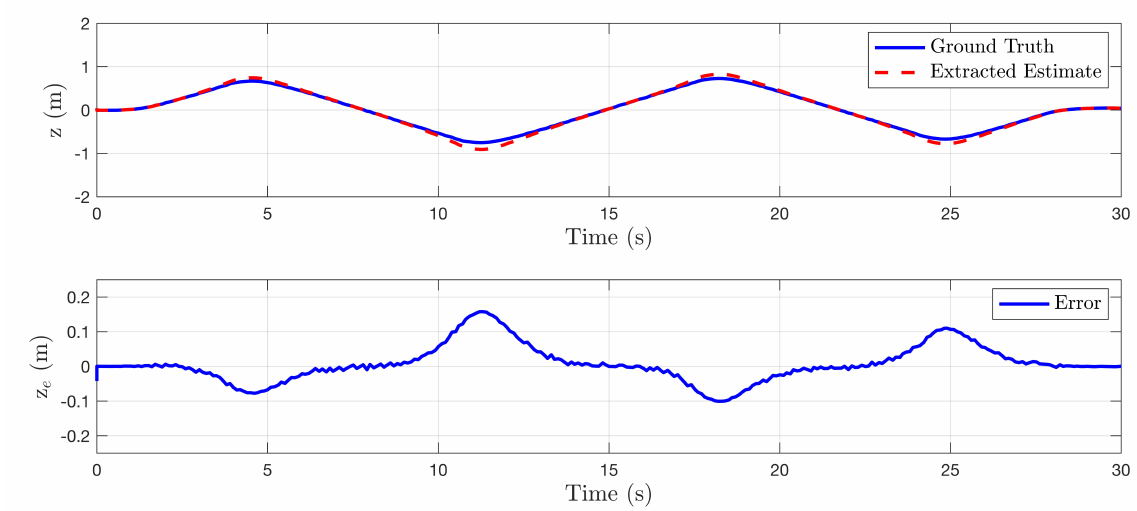
Figure 7. ( top ) Comparison of estimated vertical distance of cylinder centerline to ground truth as system moves up and down in environment. ( bottom ) State error plotted as a function of time.